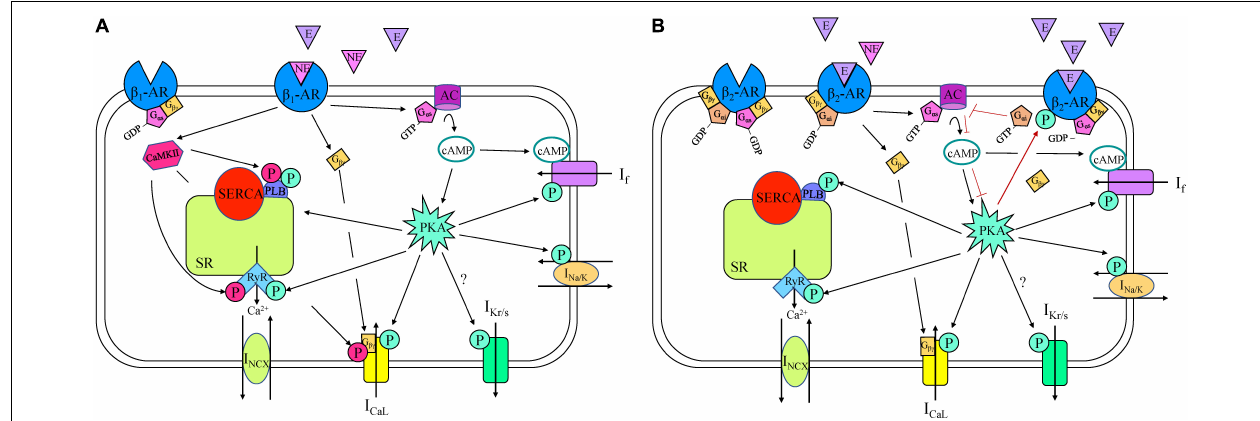
FIGURE 2 | β 1 - (A) and β 2 - (B) adrenergic receptor (AR) signaling cascades in a sinoatrial node myocyte. AC, adenylyl cyclase; Ca 2 + , calcium; CaMKII, Ca 2 + /calmodulin-dependent protein kinase; cAMP, cyclic adenosine monophosphate; E, epinephrine; GDP, guanosine diphosphate; GTP, guanosine triphosphate; I CaL , long-lasting (L-type) Ca 2 + current; I f , “funny” current; I K r / s , rapid/slow delayed rectifier K + current; I Na / K , Na + -K + ATPase current; I NCX , Na + -Ca 2 + exchanger current; NE, norepinephrine; P, phosphorylation; PKA, phosphokinase A; PLB, phospholamban; RyR, ryanodine receptor, SERCA, sarco/endoplasmic reticulum Ca 2 + -ATPase; SR, sarcoplasmic